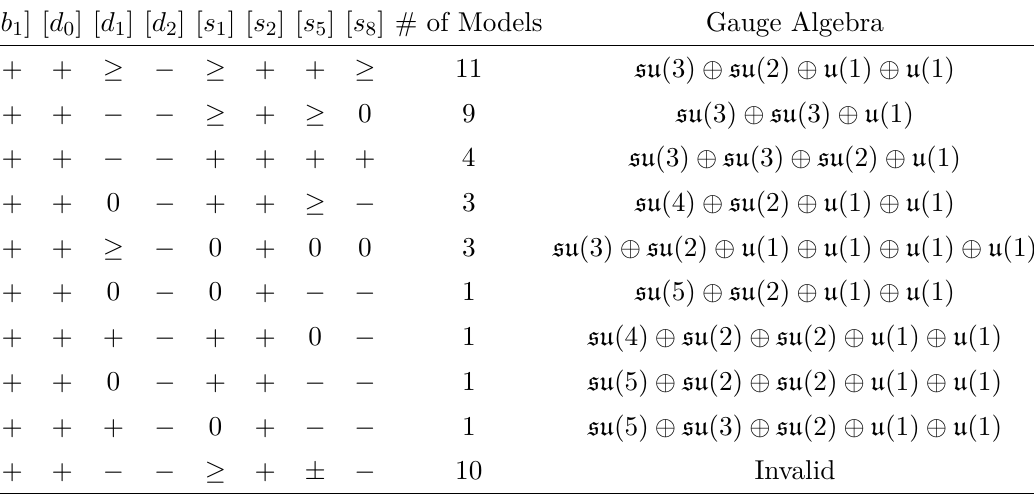
Table 3 . Cases where the (SU(3) × SU(2) × U(1)) / Z 6 universal Weierstrass model undergoes automatic enhancement over the base P 2 . Cases are grouped by their resulting gauge algebra, which is determined by which divisor classes [ b ] – [ s ] associated with parameters in the Weierstrass 3 8 model are strictly effective ( + ), effective ( ≥ ), trivial ( 0 ), ineffective ( − ), or unspecified ( ± ). The parameter s is not listed and always has class − K = 3 H 6 B